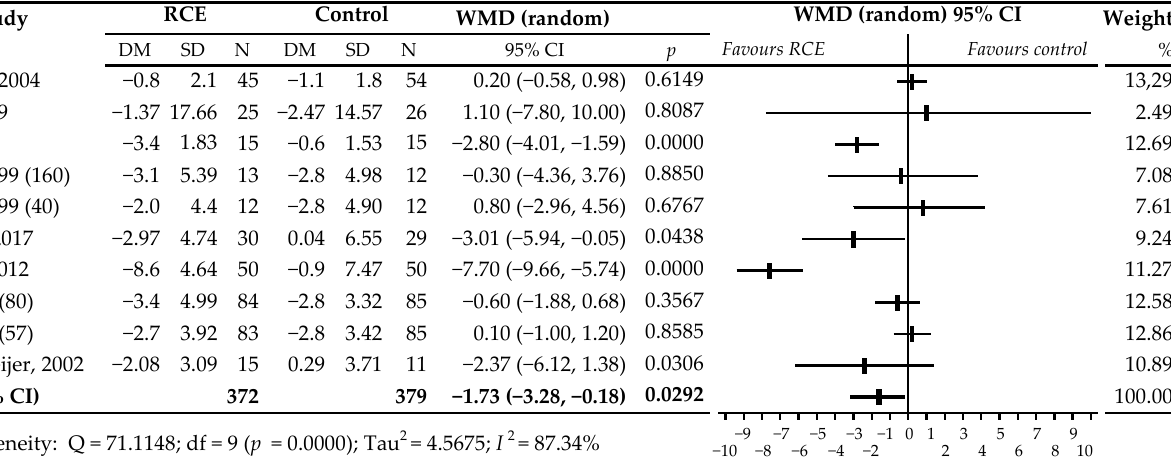
Figure 4. Effects of isoflavones with red clover (Trifolium pratense) vs. placebo on the daily frequency of hot flushes in peri- and post-menopausal women. Number in brackets following author's name refers to dose of isoflavones in the study with more than one active group, [33–38,41,44]. Abbreviations: RCIE, red clover isoflavone extract; WMD, weighted mean dif- ference. Table 2. Assessment of the effect of red clover isoflavones on the frequency of hot flushes in sub- group analysis .